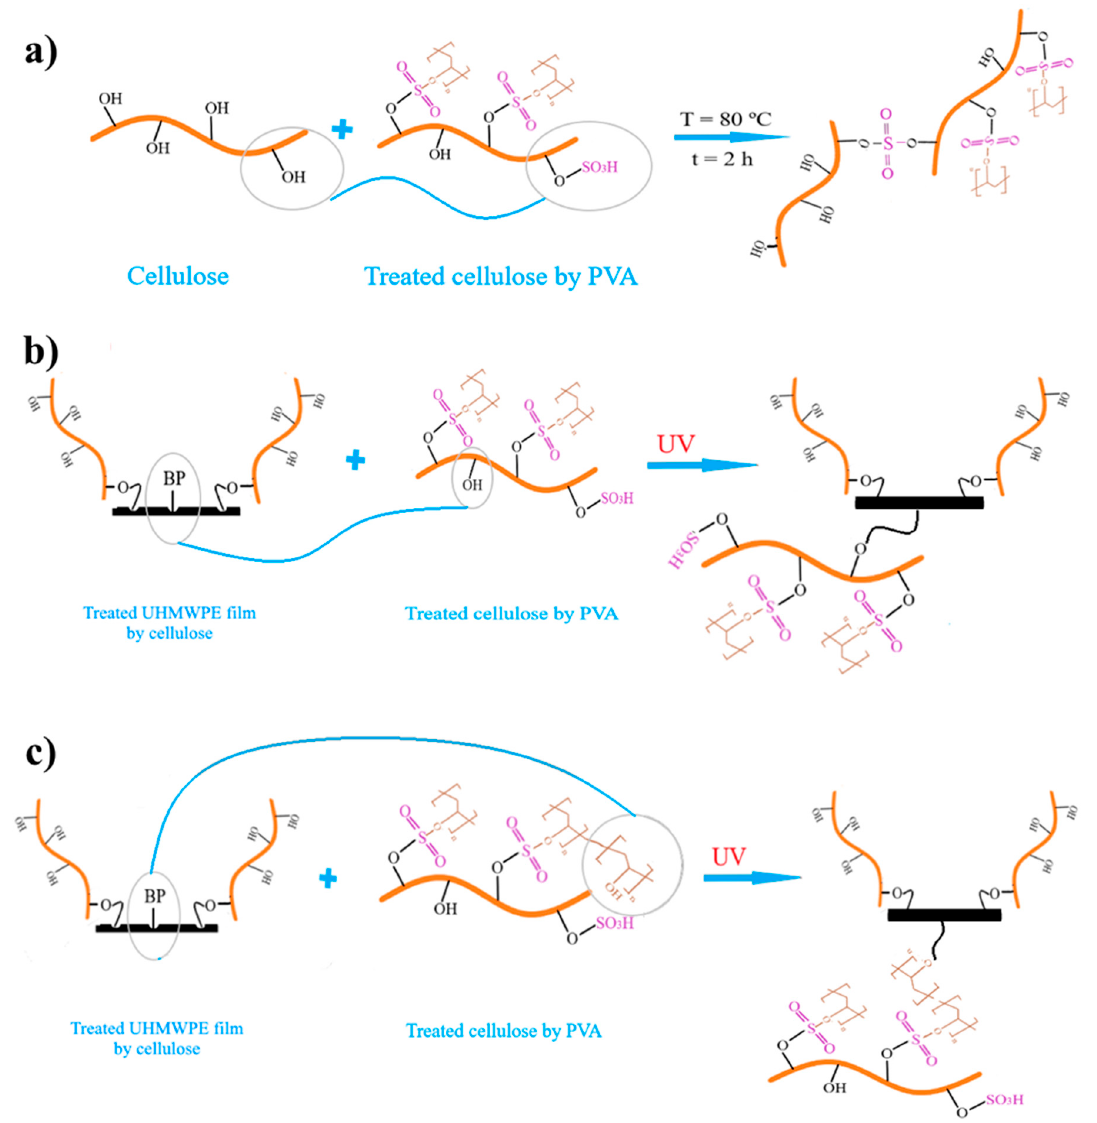
Figure 3. The potential reactions between the modified UHMWPE surface and PVA / Cellulose glue: ( a ) hydroxyl groups of cellulose and sulfuric acid groups, ( b ) residual benzophenone and hydroxyl groups of the cellulose of the glue, ( c ) residual benzophenone and hydroxyl groups of the PVA of the glue.